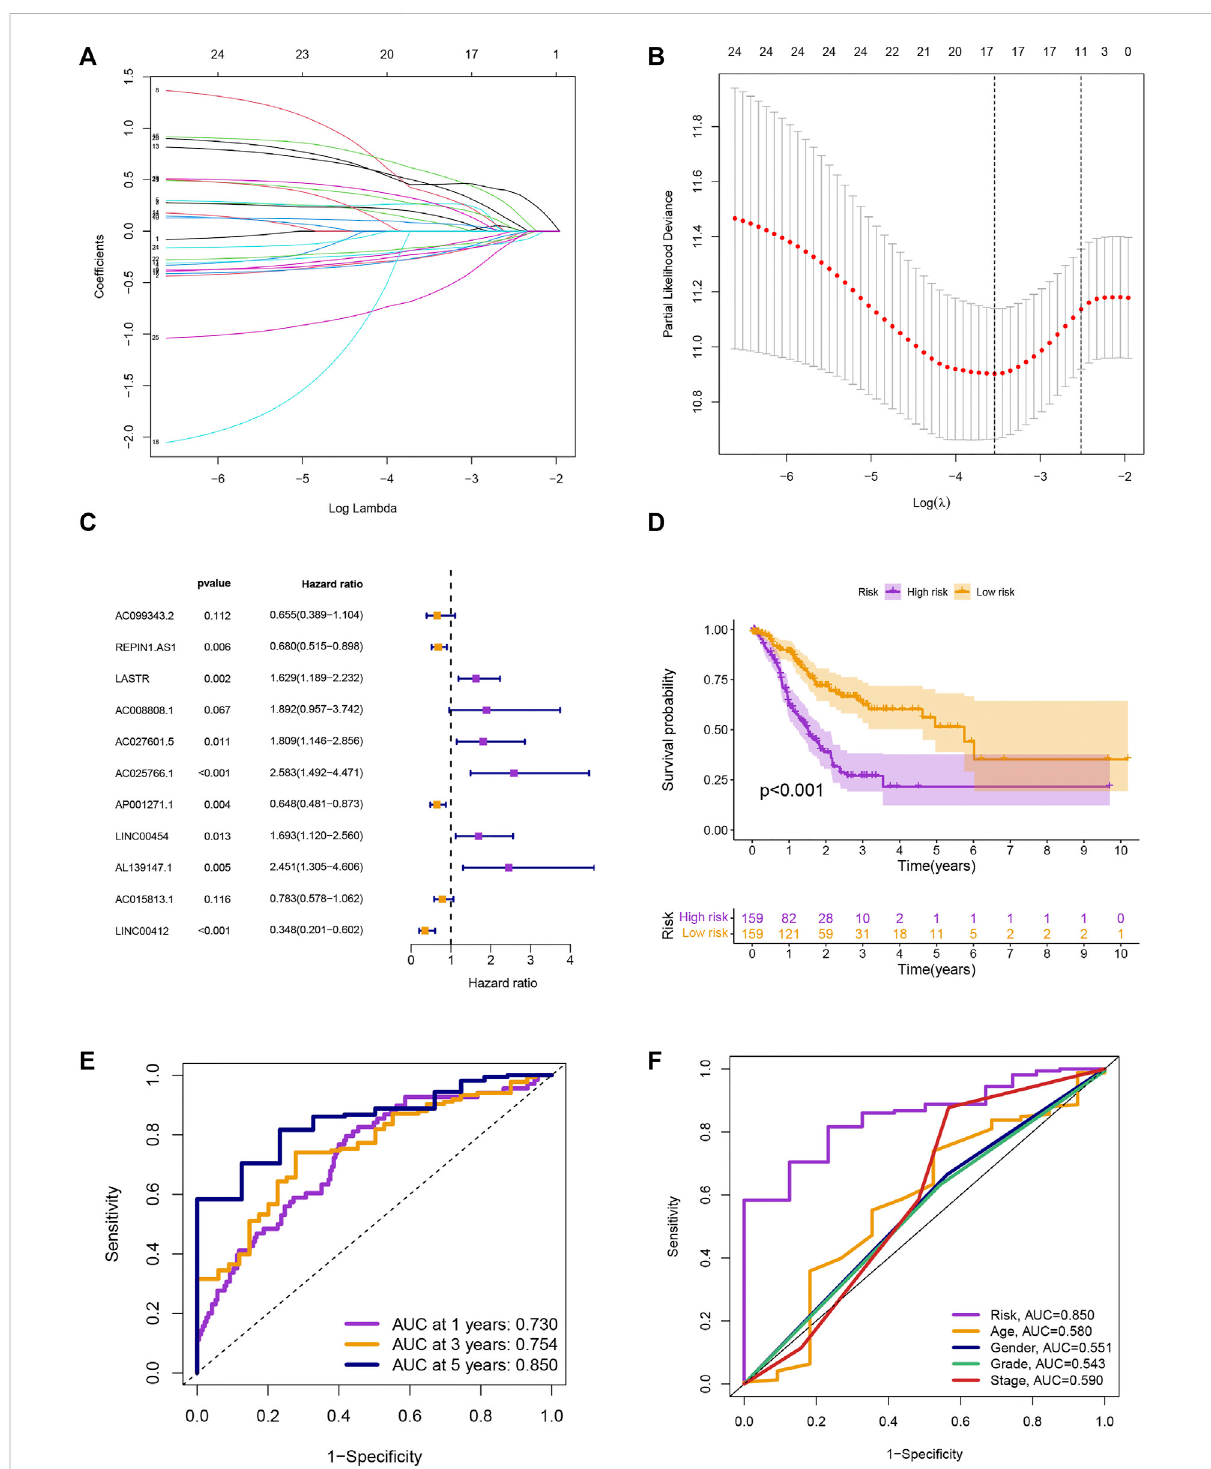
FIGURE 2 Development of risk model. (A) The LASSO coef fi cient pro fi le. (B) Coef fi cient pro fi le plot. (C) Multivariate Cox regression analysis showed 12 prognostic lncRNAs. (D) Kaplan-Meier curves of the SP in different risk groups. (E) ROC curves to predict the sensitivity of 1-, 3-, and 5-year survival. (F) ROC curves to predict the sensitivity of the risk grade and other clinicopathological